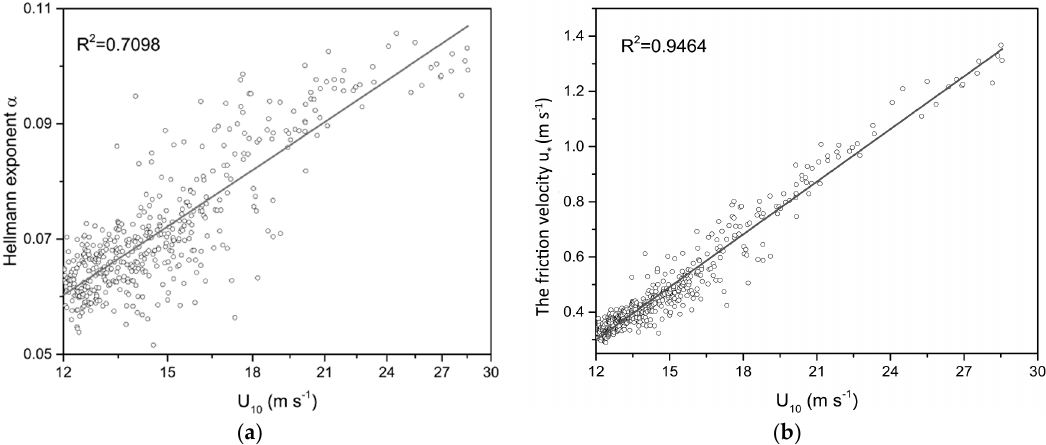
Figure 12. The fitted curves for: ( a ) the Hellmann exponent α ; and ( b ) the friction velocity u ∗ under typhoon conditions.